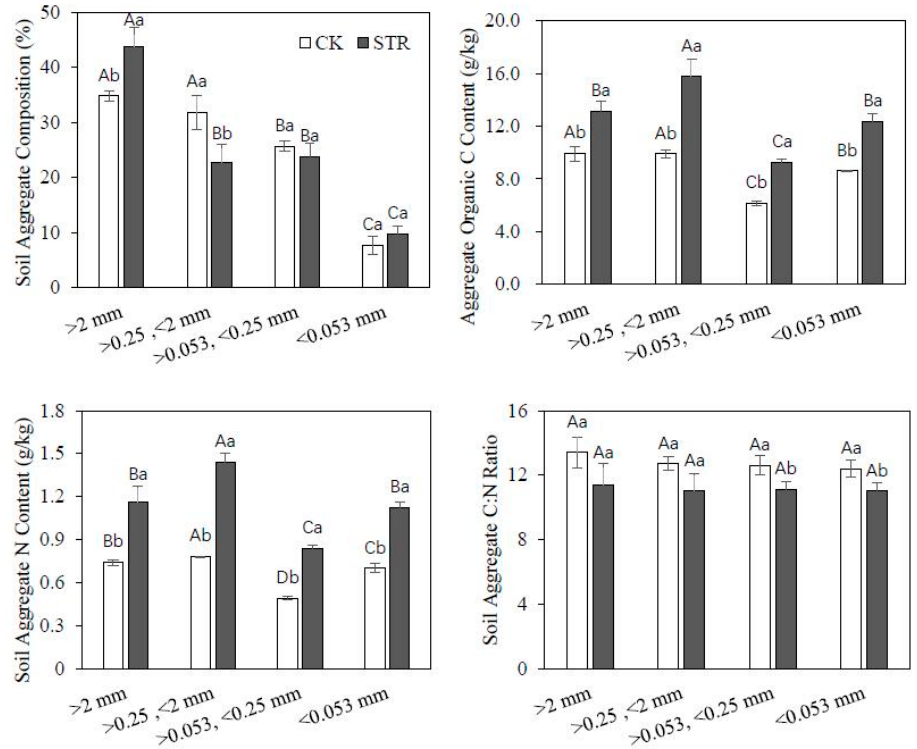
Figure 3. Soil aggregates and their C and N contents as affected by straw management. Different uppercase letters above columns for the same treatment indicate a significant difference ( p < 0.05); different lowercase letters above columns for the same aggregate size between treatments indicate a significant difference ( p < 0.05).